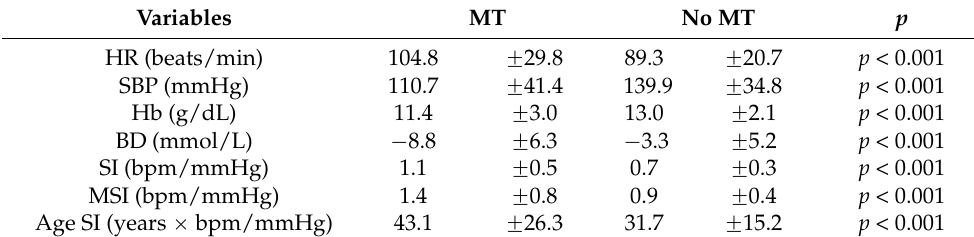
Table 2. Physiological response and parameters of patients with and without MT.